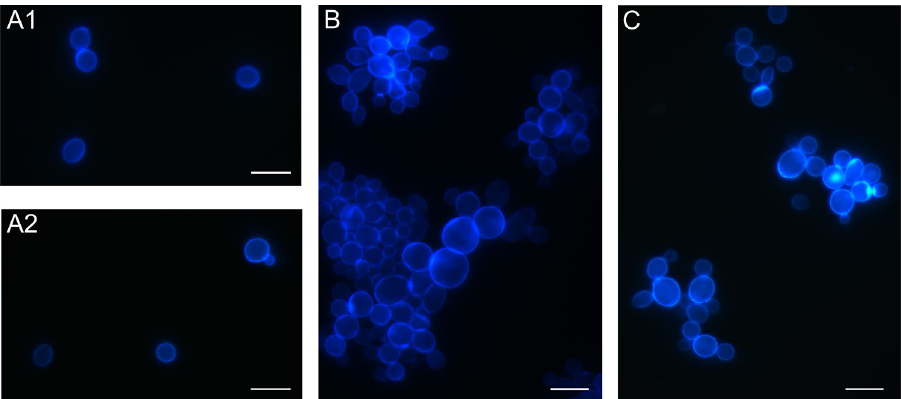
Figure 1. Images of aggregates of C. albicans cells after the staining with Calcofluor white: ( A1 )–( A2 )-control C. albicans cells; ( B )- C. albicans cells after treatment with Venetin-1 at 100 µg mL −1 ; ( C )- C. albicans cells after incubation with fluconazole at 20 µg mL -1 . The scale bar represents 5